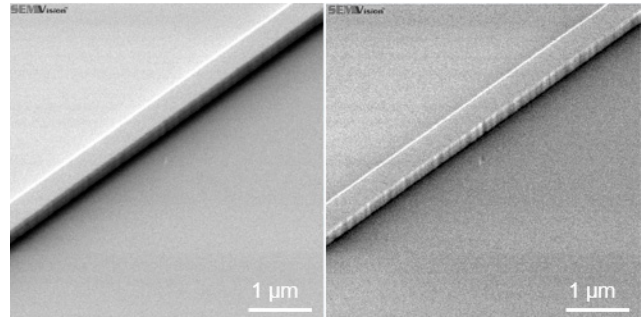
8 of 25 Figure 6. Passive device manufacturing. Schematic representation of the main process steps: ( a ) SOI wafer as starting material, ( b ) silicon dioxide hard mask deposition, ( c ) silicon structuring by time- controlled shallow etching, ( d ) complete silicon etching in selected areas, ( e ) silicon dioxide top cladding deposition with Chemical-mechanical polishing (CMP) planarization. 3.1. Waveguides